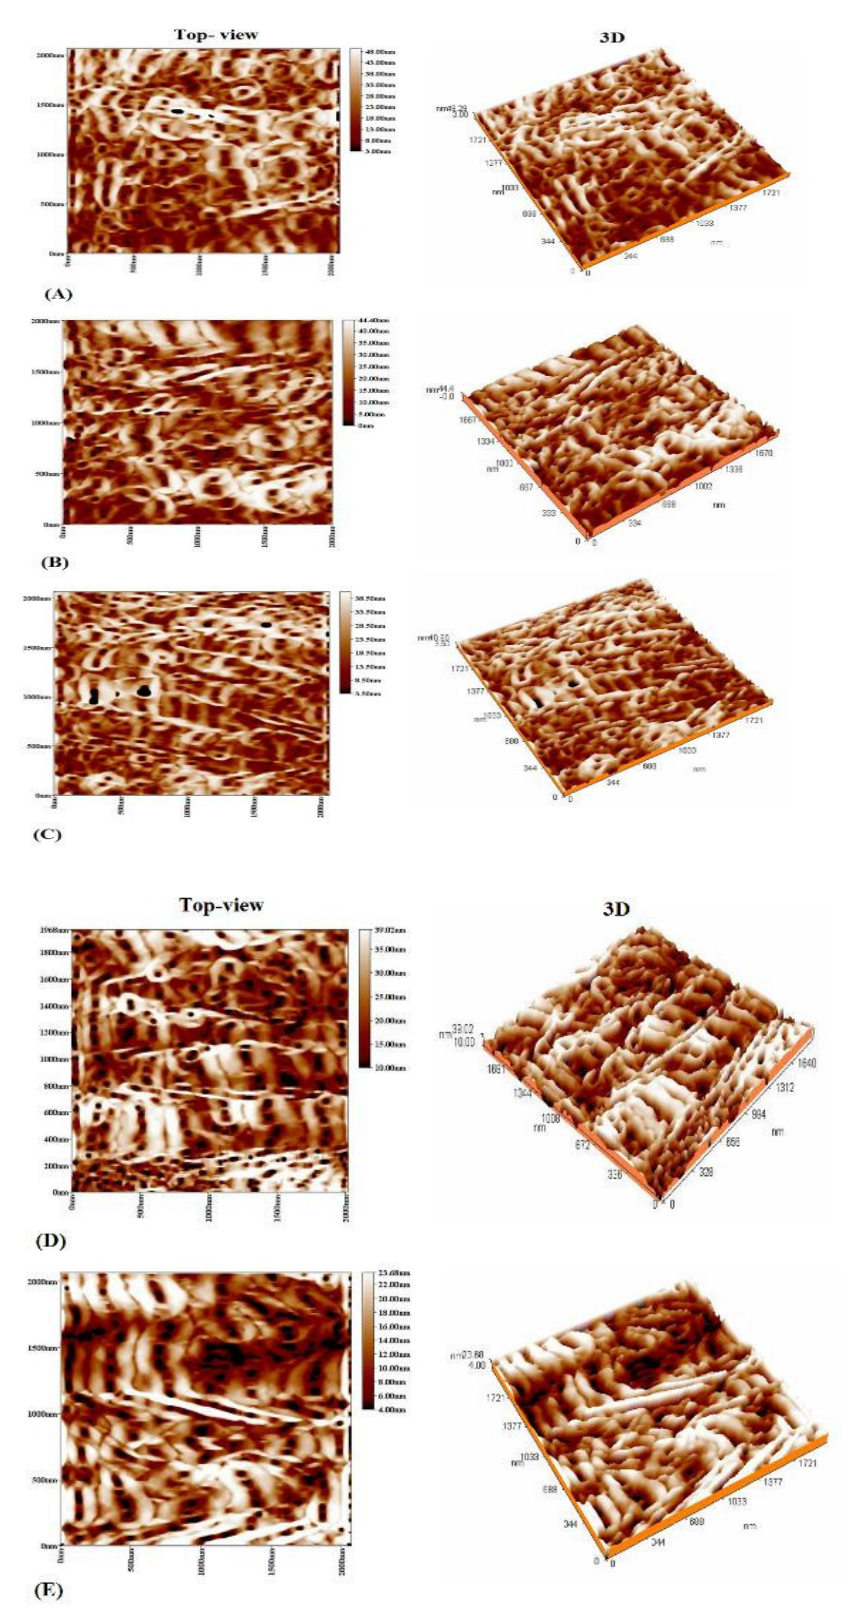
Fig. 2. Three-dimensional and top view AFM pictures of the inner surface of the hollow fiber blend membranes: (A) PS1, 1 wt.%, (B) PS2, 2 wt.%, (C) PS3, 3 wt.%, (D) PS4, 4 wt.%, (E) PS6, 6